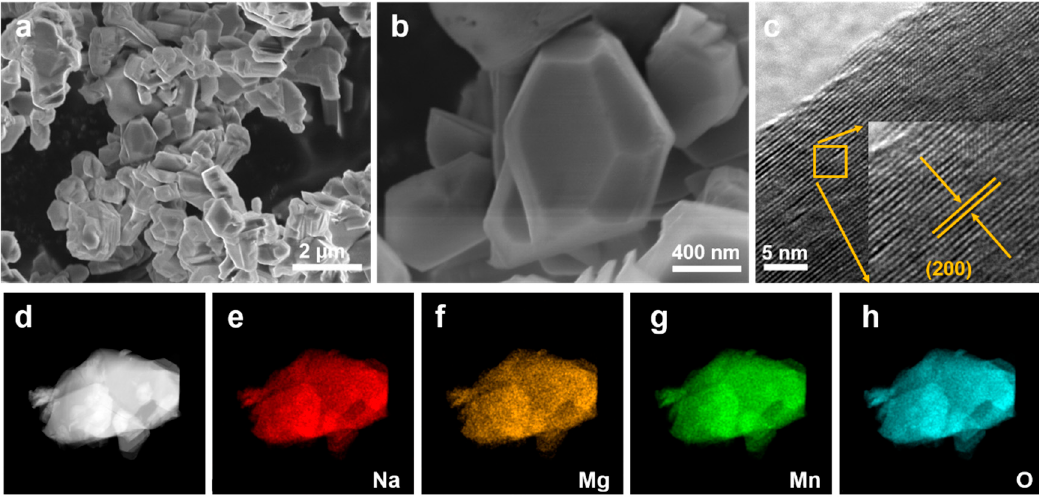
Figure 2. ( a , b ) SEM images of NaMMO particles. ( c ) HRTEM images at the (200) zone axis. ( d–h ) EDS mappings.